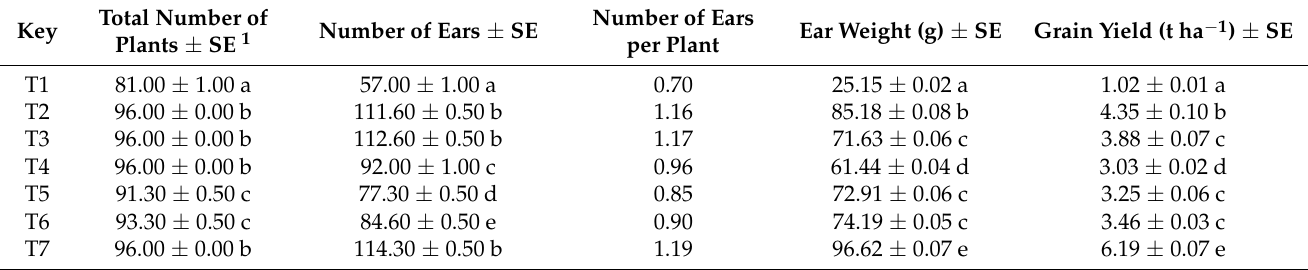
Table 4. Data derived from the yield variables evaluated in the fertilization schemes studied.